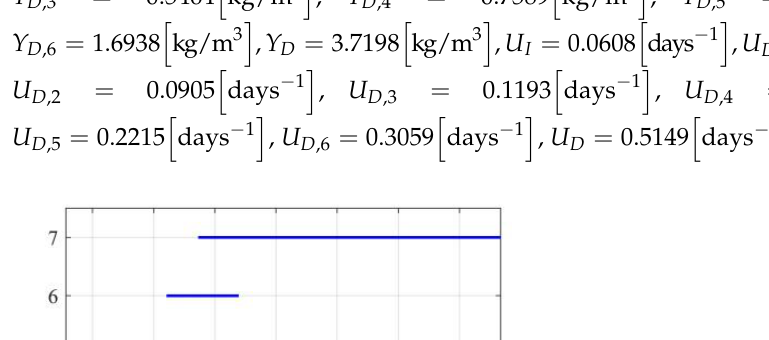
Figure 5. ( a ) Substrate concentration response and estimation for single step transition; ( b ) Micro-